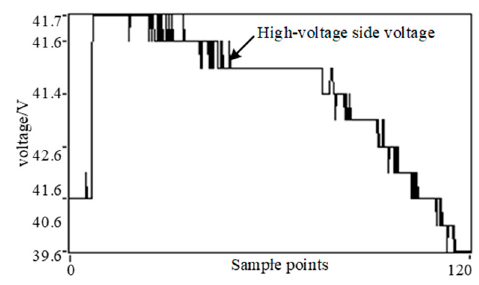
Figure 20. High-voltage terminal voltage.